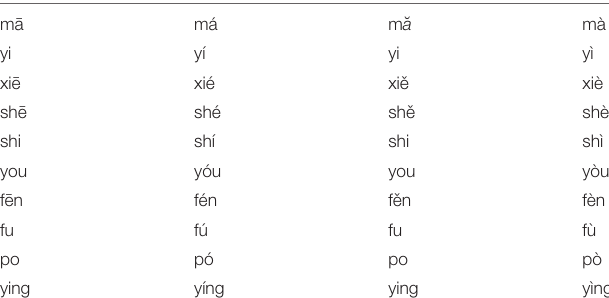
TABLE A1 | List of words used for producing the stimuli.